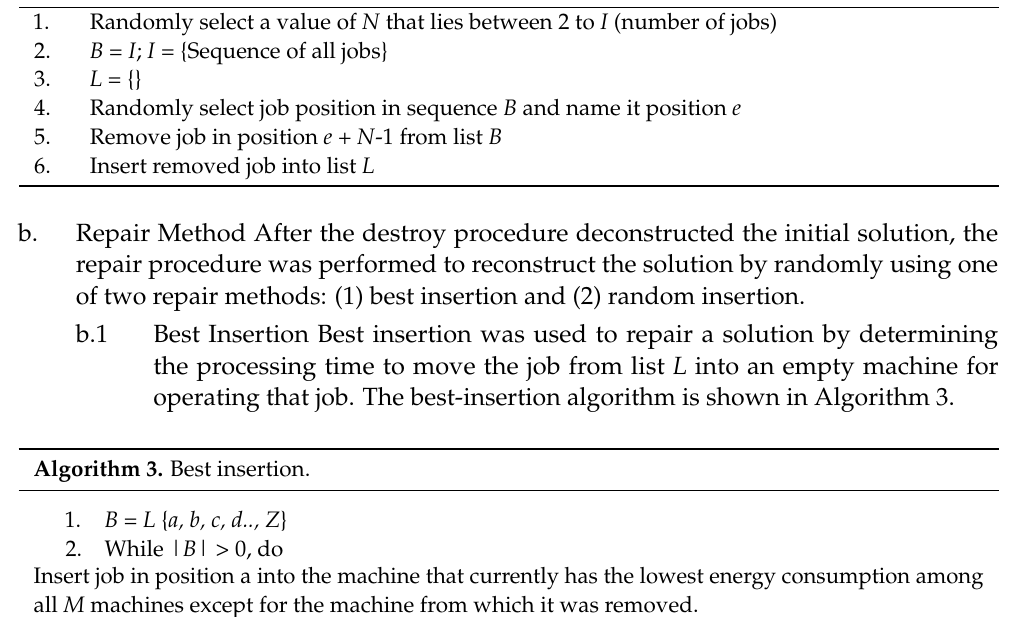
Algorithm 2. N-job-string